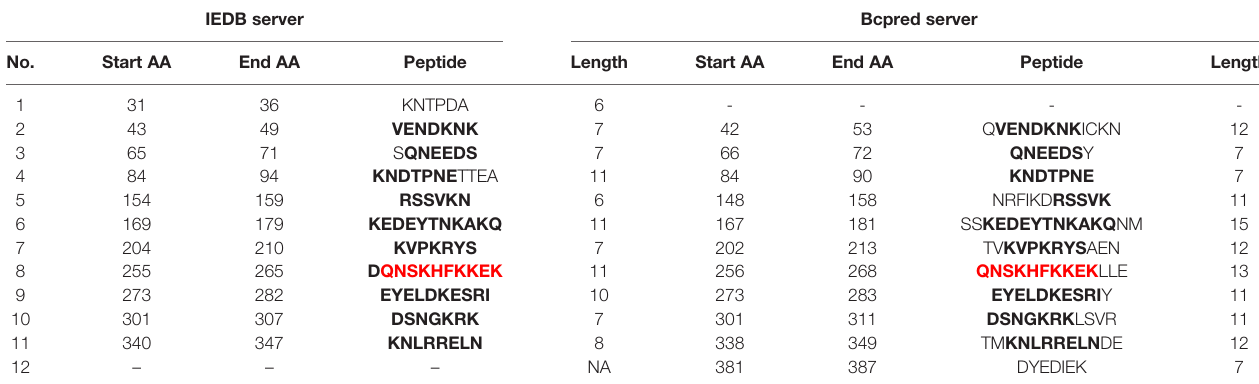
The common amino acids within an epitope predicted by both servers are indicated in bold. Amino acids in red indicate the conserved epitope among all species.